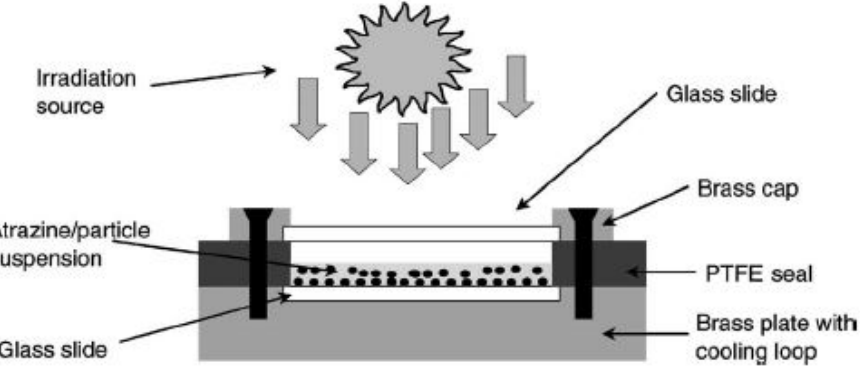
Figure 4. Schematic setup of an irradiation chamber (ref. [37]).